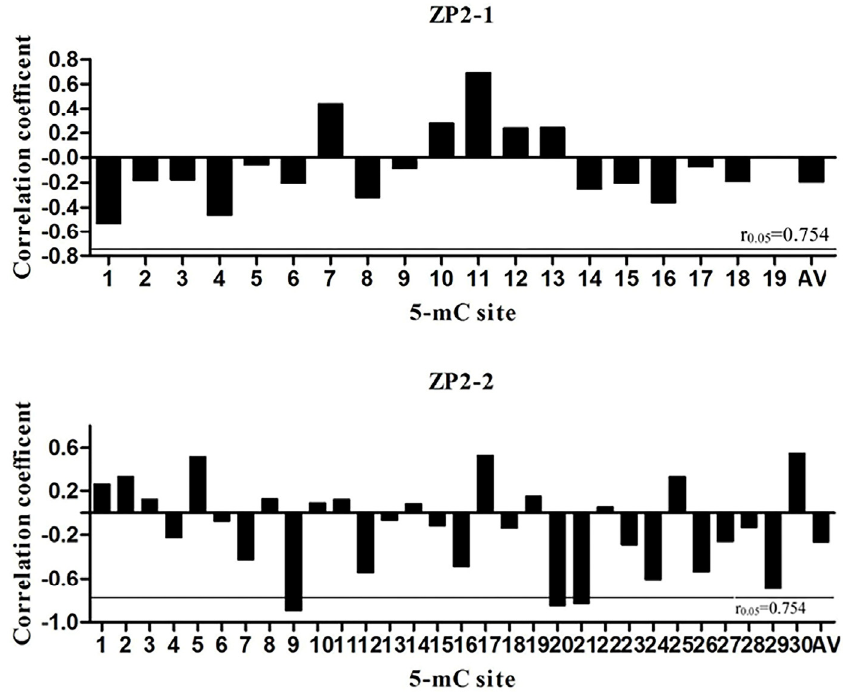
Figure 4. Correlation analysis between ZP2-1, ZP2-2 amplified fragment methylation, and mRNA expression level. AV: The average level of methylation. The 5-mC site: the 5-methylcytosine site formed after DNA methylation is an important epigenetic modification.